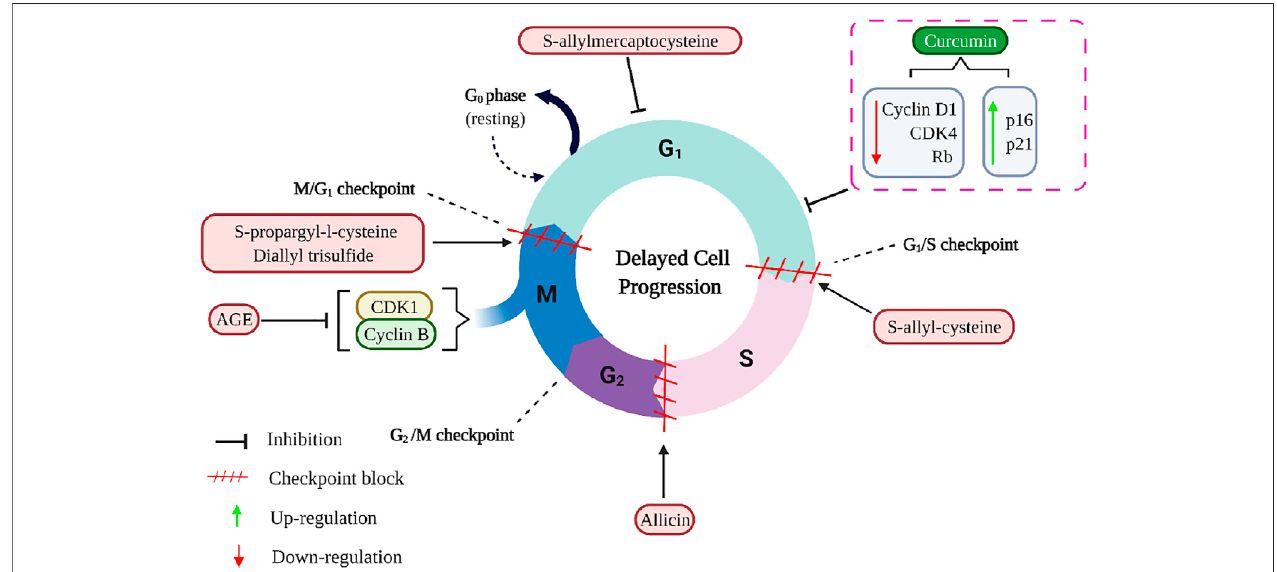
FIGURE8| Themechanismsofcurcuminandagedgarlicextracts,includingitsactivecompounds,inhibitthecellcycleincancercells.AGEdown-regulatesCyclin B1andCDK1andarrestthecellcycleintheG2/M-checkpoint.S-propargyl-L-cysteineanddiallyltrisul fi dearrestthecellcycleintheG2/M-checkpoint,whereasS-allyl- cysteine induced cell cycle arrest in the G1/S- checkpoint, and allicin induced cell cycle arrest during the S phase. Additionally, S-allylmercaptocysteine shortens the duration of the S phase and lengthens the duration of the G0/G1 phase. The dotted rectangle indicates the curcumin (lead compound of turmeric) functions. AGE, Aged garlic extract; CDK1, Cyclin-dependent kinase 1; CDK4, Cyclin-dependent kinase 4; Rb, Rb